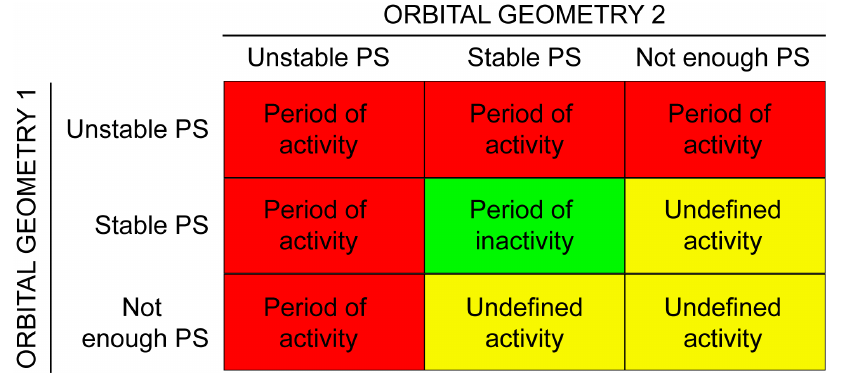
Figure 6. State of activity matrix based on combination of double orbital observation geometries (ascending and descending).